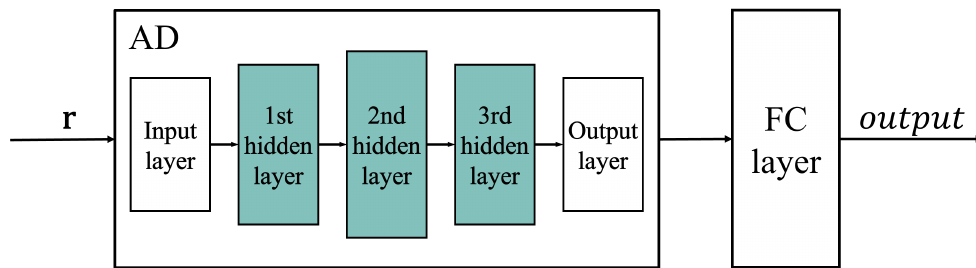
Figure 3. Structure of RM decoder based on AD.